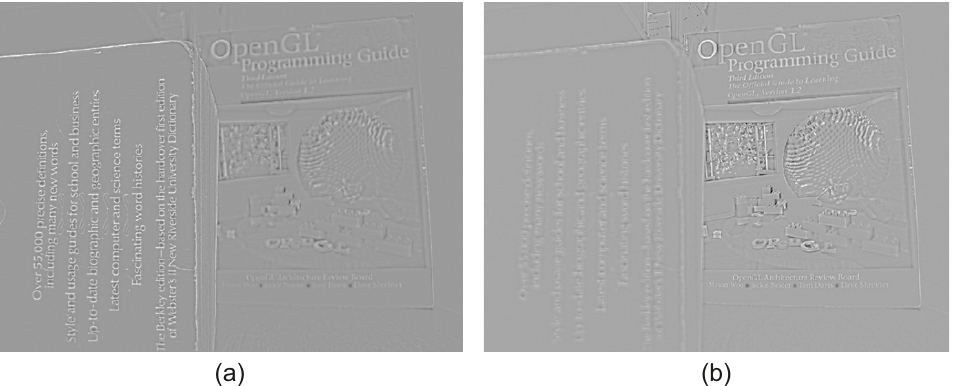
Figure 4. High frequency of input images: ( a ) High frequency of near focused image, ( b ) High frequency of far focused